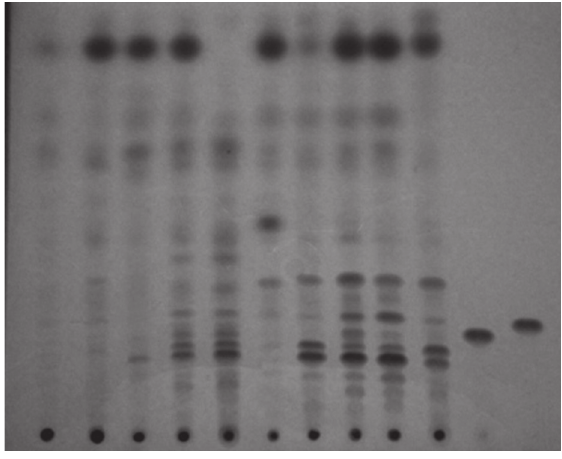
Figure 4 - Thin layer chromatographic profile (silica; hexane: ethyl acetate: isopropanol 70:28:02; sulfuric anisaldehyde) of extracts from leaves of C. sylvestris . Samples (from left to right): AGS38, AGS51, AGS43, AGS45, AGS44 (var. lingua